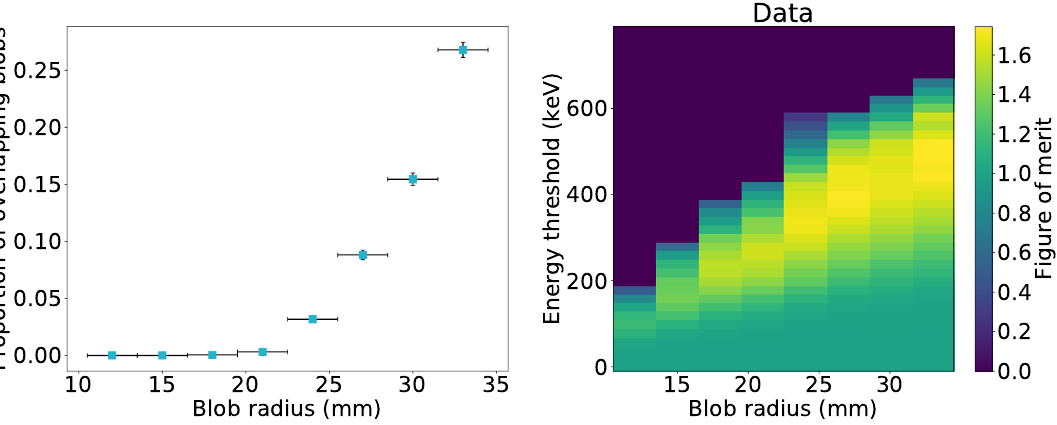
Figure 11 . Proportion of events with overlapping blob candidates (left) and dependence of the (cid:12)gure of merit on the blob radius and the energy threshold on the blob candidate 2 (right). SEJI/2017/011; the Portuguese FCT under project PTDC/FIS-NUC/2525/2014,